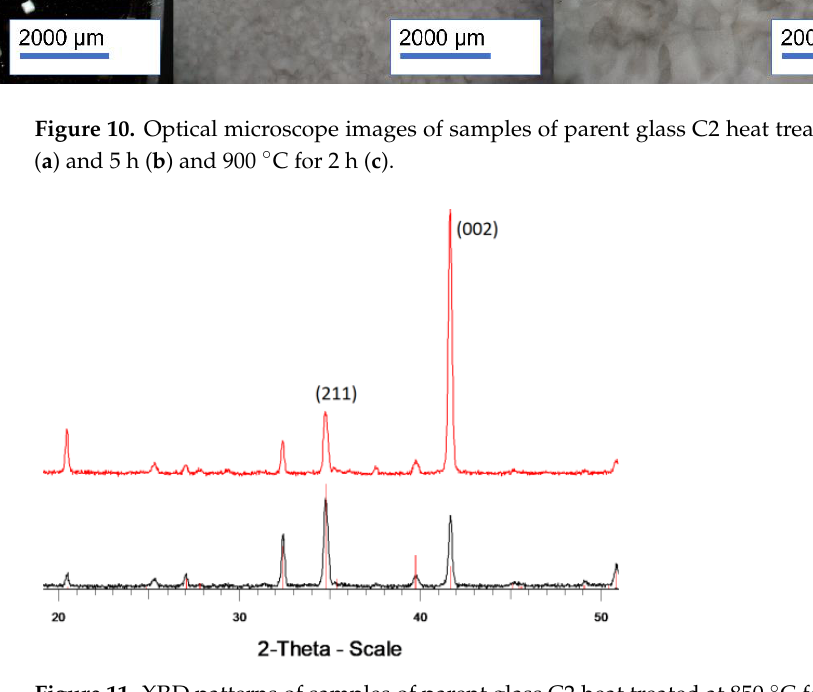
Figure 11. XRD patterns of samples of parent glass C2 heat treated at 850 °C for 5 h (black pattern) and 900 °C for 1 h (red pattern).